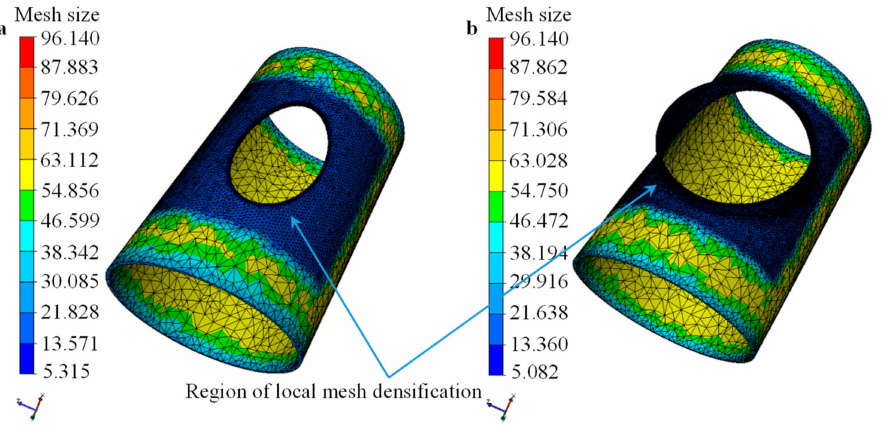
Figure 5. Distribution of mesh size for billet / workpiece: ( a ) initial mesh; ( b ) mesh after flanging process.